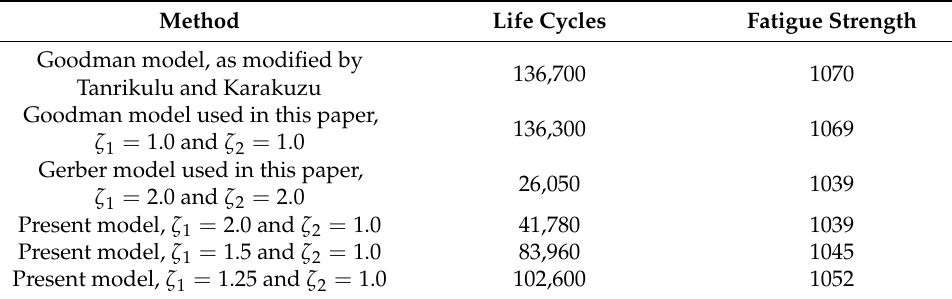
Table 4. Life cycle predictions of the various MSCDs. Method Life Cycles Fatigue Strength Goodman model, as modified